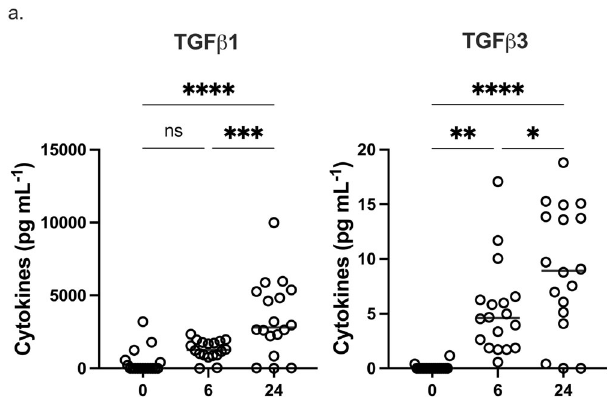
Fig. 4 eLNP treatment promotes TGF-B secretion. a Dynamics of TGF- β secretion from PBMCS at 0, 6, and 24 h after eLNP stimulation. n = 18. Data were combined from at least two independent experiments. Each individual circle represents one individual subject. Data are from one independent experiment ( a ) One-way ANOVA followed by Tukey ’ s test was applied